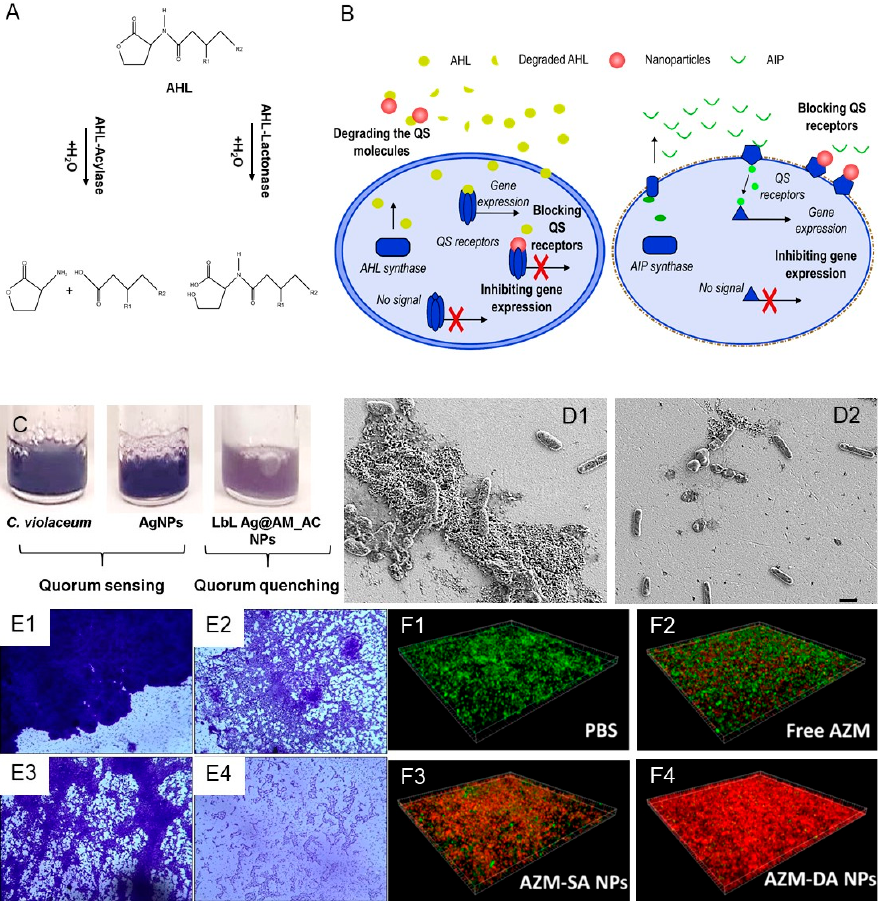
Figure 1. ( A ) Degradation of AHLs signals by quorum-quenching enzymes lactonase and acylase. ( B ) Schematic representation of QS process in Gram-positive and Gram-negative bacteria and different mechanisms for its inhibition. Gram-negative bacteria produce acyl-homoserine lactones (AHLs, yellow circles), while Gram-positive secrete autoinducer peptides (AIPs, green lines). When the concentration of these molecules reaches a certain threshold, the genes related with virulence and biofilm formation are expressed. Nanoformulated QQE, QSI, or metals are employed to degrade the QS signals outside the cells or block the cognate QS receptors in bacteria. ( C ) Inhibition of bacterial virulence by Ag NPs coated with aminocellulose and acylase I assessed through the decrease in the QS-regulated violacein production by C. violaceum (reproduced from [33] under the terms of the Creative Commons Attribution International License (CC BY 4.0)). ( D ) SEM images of untreated P. aeruginosa biofilm ( D1 ) and treated with acylase loaded NPs ( D2 ) (reproduced from [28] under the terms of the Creative Commons Attribution International License (CC BY 4.0)). ( E ) Light microscopic images of the untreated P. aeruginosa ( E1 ) and S. marcescens MTCC 97 biofilms ( E3 ), and in the presence of AuNPs synthesized using C. annuum extract ( E2 and E4 , respectively)